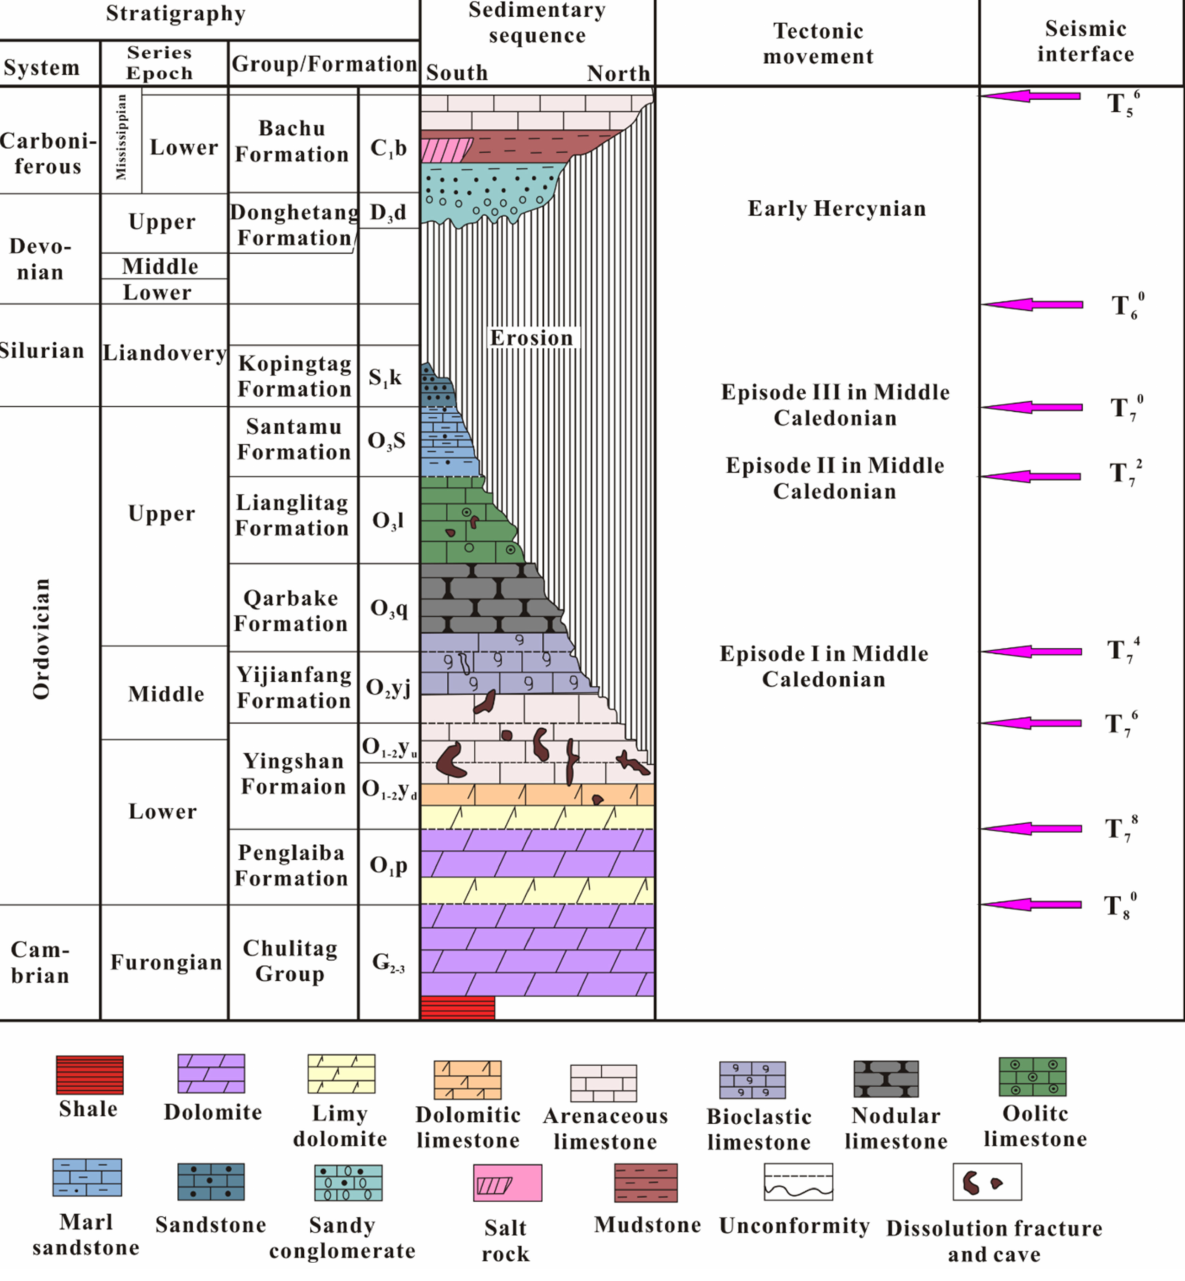
Figure 2. Stratigraphic column of the Tahe oilfield, from the Upper Cambrian to the Lower Carbonif- erous (modified from